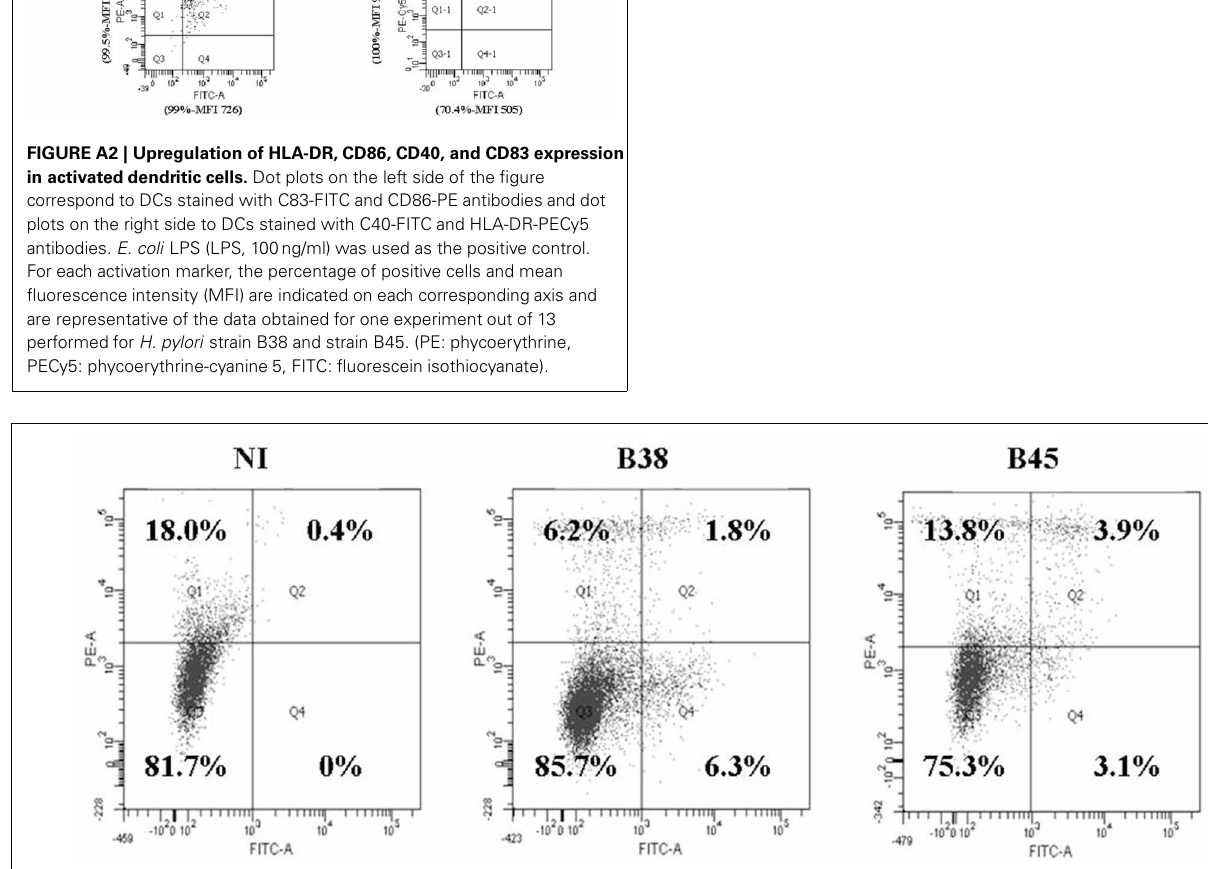
(propidium iodure positive-FITC negative in Q1), and apoptotic DCs (FITC-positive, propidium iodure ± in Q2 and Q4) are depicted in each area. The percentages are shown for one representative experiment out of 3 independent experiments (y-axis, propidium iodure; x-axis, anti-annexin V-FITC) (NI for uninfected